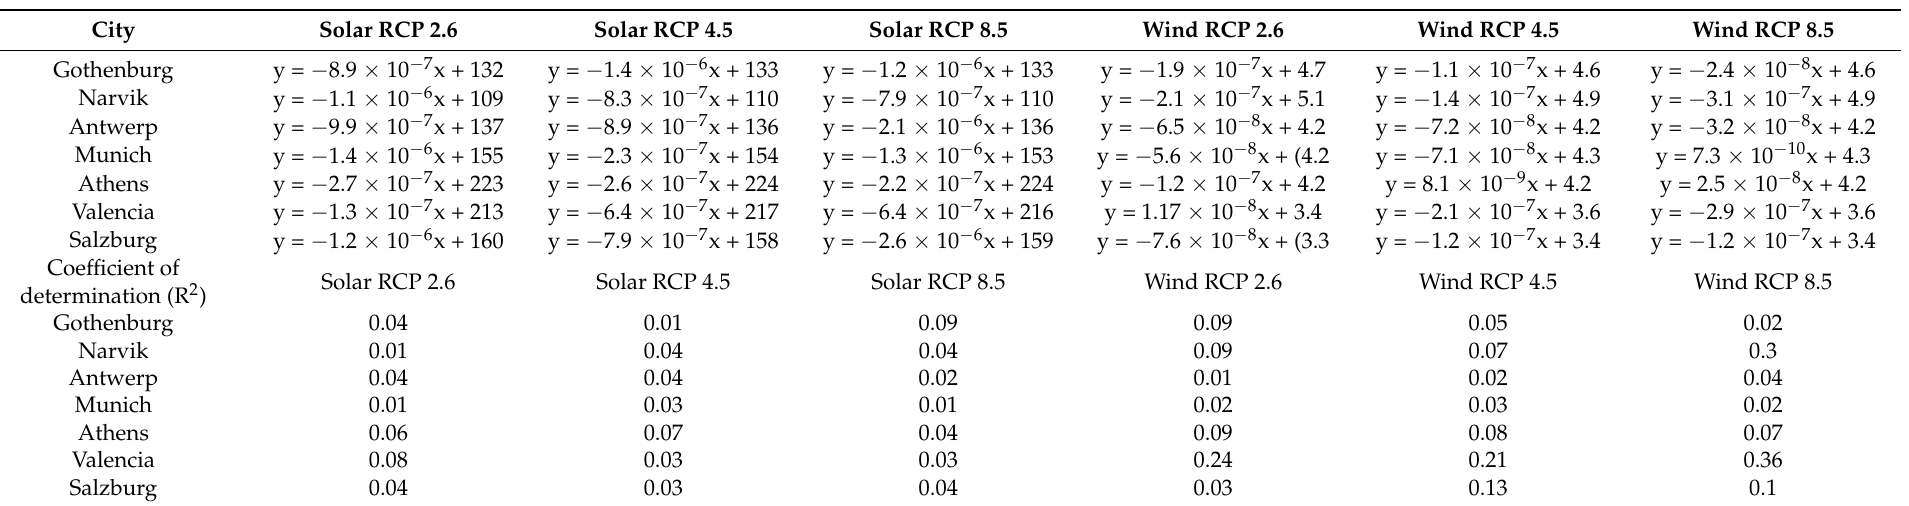
Table 1. Regression analysis for solar irradiance and wind speed of 7 European